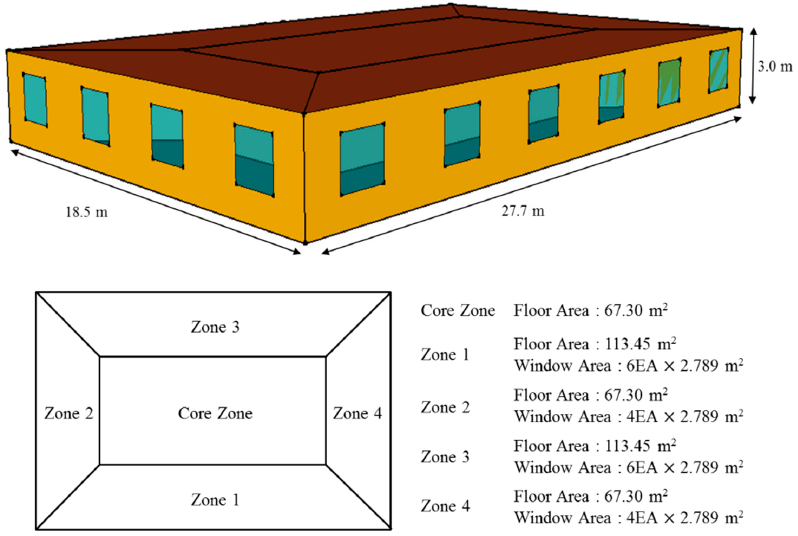
Figure 7. Building model.